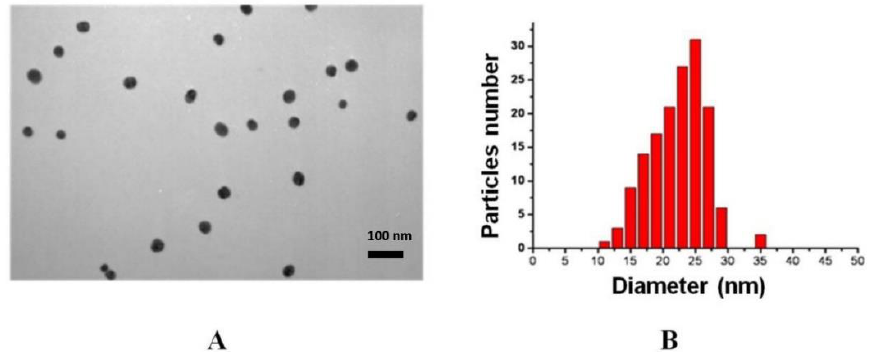
Figure 1. Micrograph of the preparation of gold nanoparticles obtained by transmission electron microscopy—enlargement 33,000 × ( A ). Histogram of the distribution of nanoparticles by diameter ( B